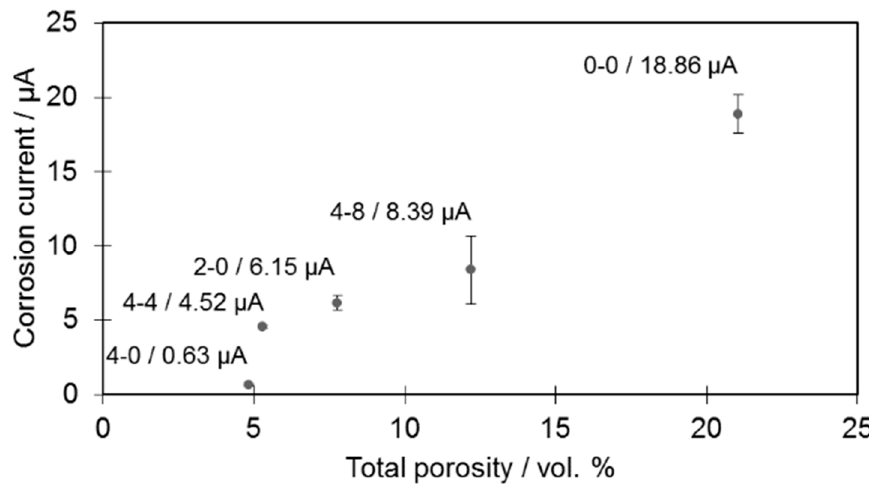
Figure 8. Corrosion current of selected samples as a function of porosity. Numerical data are available in Table S3 in the Supplementary Material.